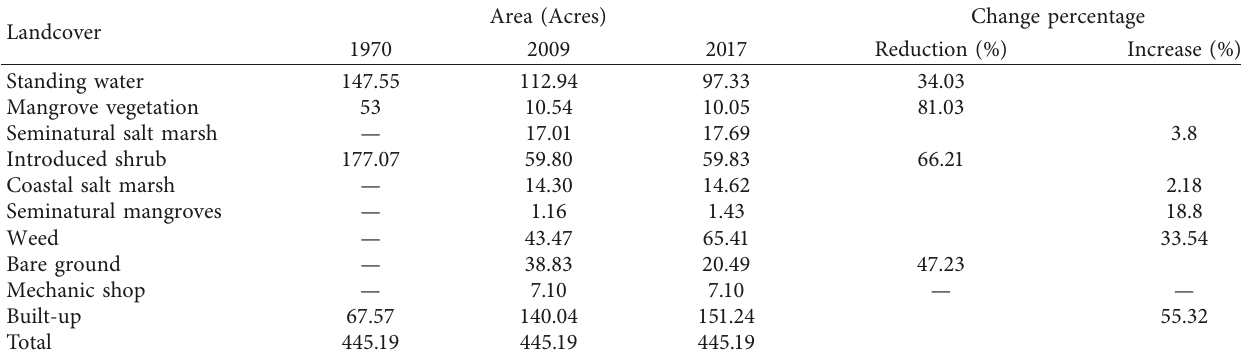
Figure 4: Habitat map of Fosu lagoon in 2017. Table 3: Landcover size and percentage change of the various vegetation around the Fosu